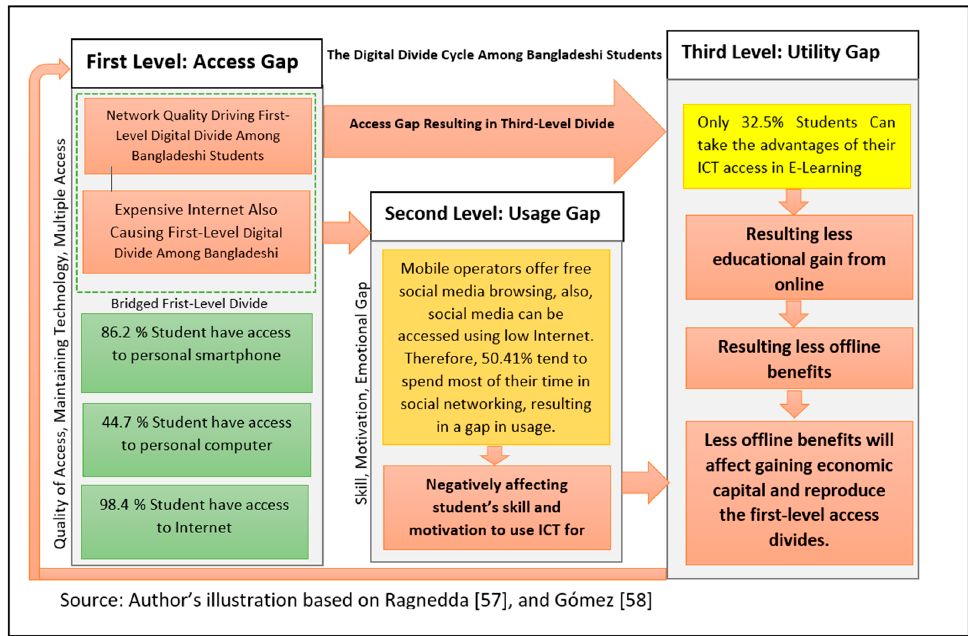
Figure 7. Illustration of digital divide among Bangladeshi students based on multi-level digital divide and bidirectional capital conversion